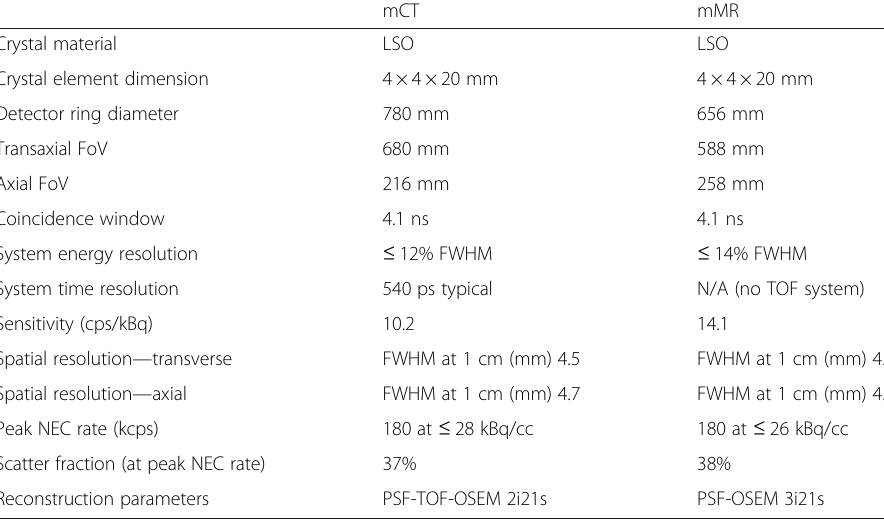
Table 1 PET system characteristics for mCT (PET/CT) and mMRI (PET/MRI) system mCT mMR Crystal material LSO LSO Crystal element dimension 4 × 4 × 20 mm 4 × 4 × 20 mm Detector ring diameter 780 mm 656 mm Transaxial FoV 680 mm 588 mm Axial FoV 216 mm 258 mm Coincidence window 4.1 ns 4.1 ns System energy resolution ≤ 12% FWHM ≤ 14% FWHM System time resolution 540 ps typical N/A (no TOF system) Sensitivity (cps/kBq) 10.2 14.1 Spatial resolution — transverse FWHM at 1 cm (mm) 4.5 FWHM at 1 cm (mm) 4.2 Spatial resolution — axial FWHM at 1 cm (mm) 4.7 FWHM at 1 cm (mm) 4.6 Peak NEC rate (kcps) 180 at ≤ 28 kBq/cc 180 at ≤ 26 kBq/cc Scatter fraction (at peak NEC rate) 37% 38% Reconstruction parameters PSF-TOF-OSEM 2i21s PSF-OSEM